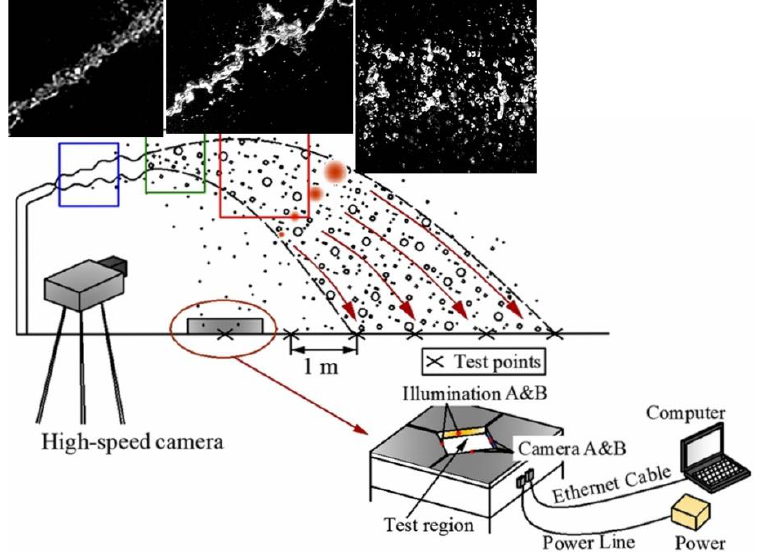
Figure 2. Schematic diagram of the experiment system.